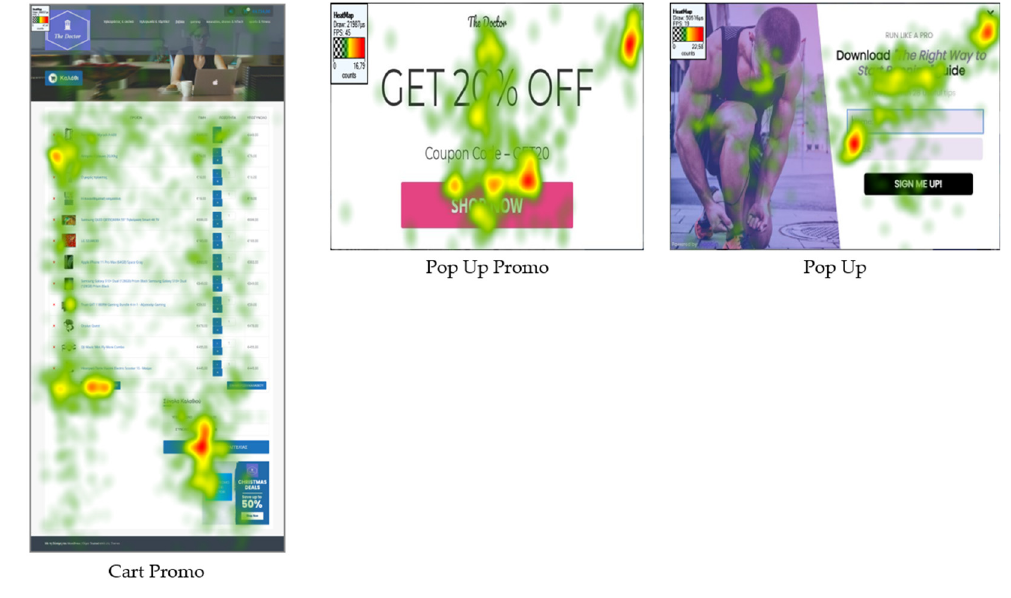
Figure 6. Heatmaps of pop-up and promotional advertisements. Table 6. Visit duration for relevant advertisements. Table 7. Visit duration for irrelevant advertisements.